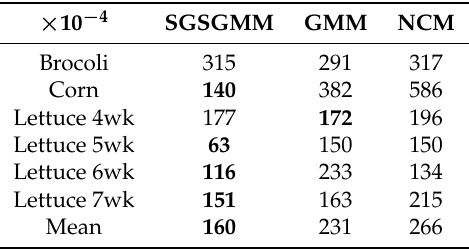
Table 6. The RMSE calculated between the probability value in each histogram and the estimated value at each bin location for the Salinas-A